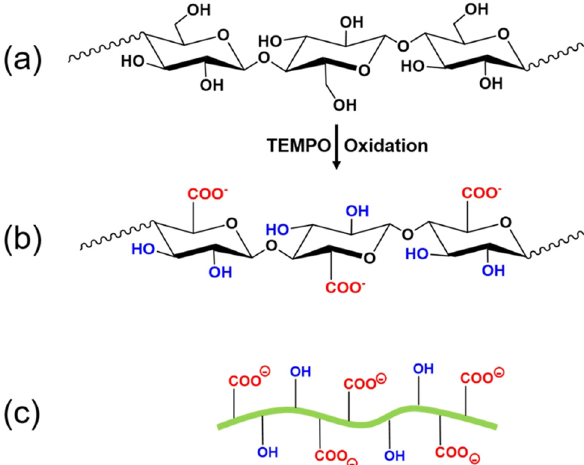
Figure 3: ( a ) Chemical structure of unmodi fi ed cellulose; ( b ) che - mical structure of carboxylated cellulose; ( c ) scheme of carboxy - lated CNFs with di ff erent groups including hydroxyl and negatively charged carboxylated groups on the surface.